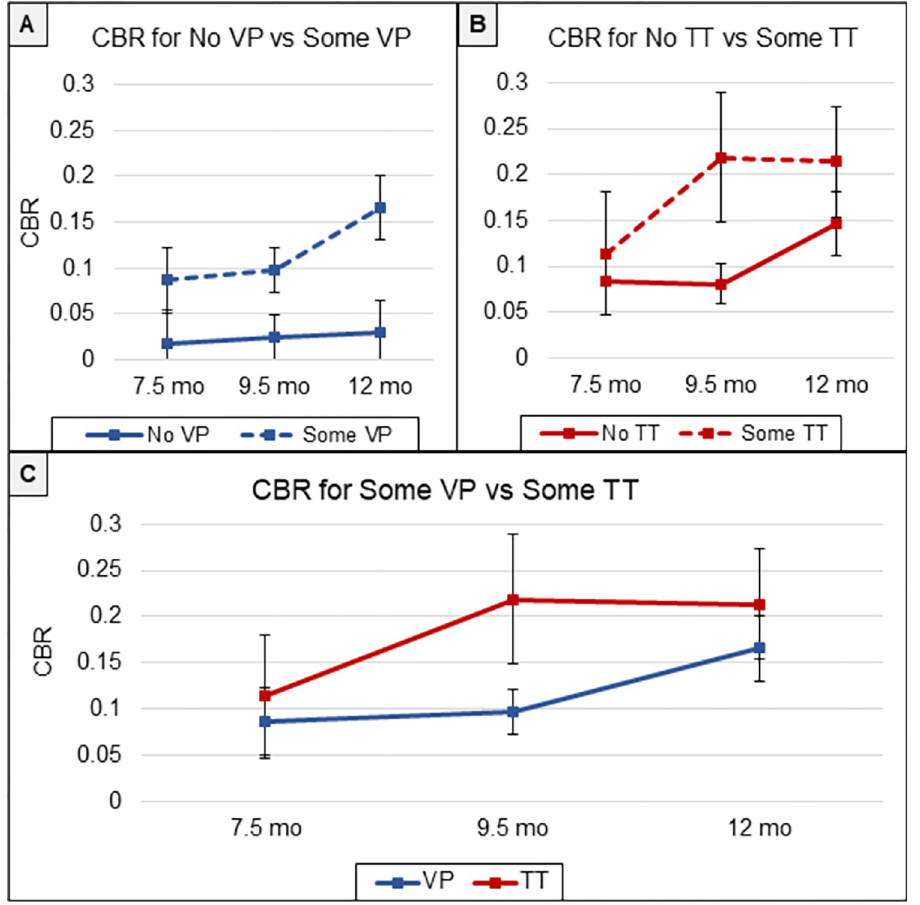
Fig 2. Canonical babbling ratios as a function of VP and TT. A. CBR was higher in segments judged to have Some VP than No VP. The difference was clear at all three Ages. B. CBR was higher in segments with Some TT than in segments with No TT. The pattern was most notable at 9.5 mo. C. Comparing the data for Some VP and Some TT, the data showed significantly higher CBRs for segments with Some TT than for segments with Some VP. The error bars for all the panels represent 95% confidence